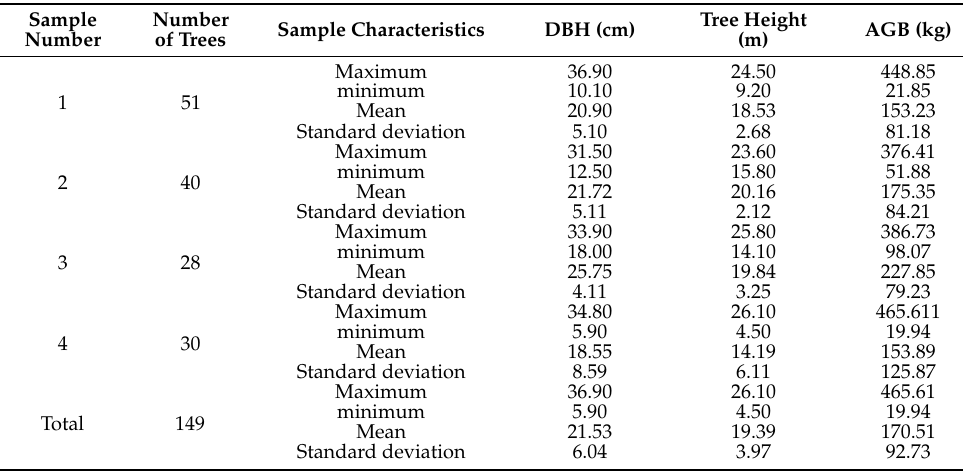
Table 4. Statistical analysis of measured data of sample